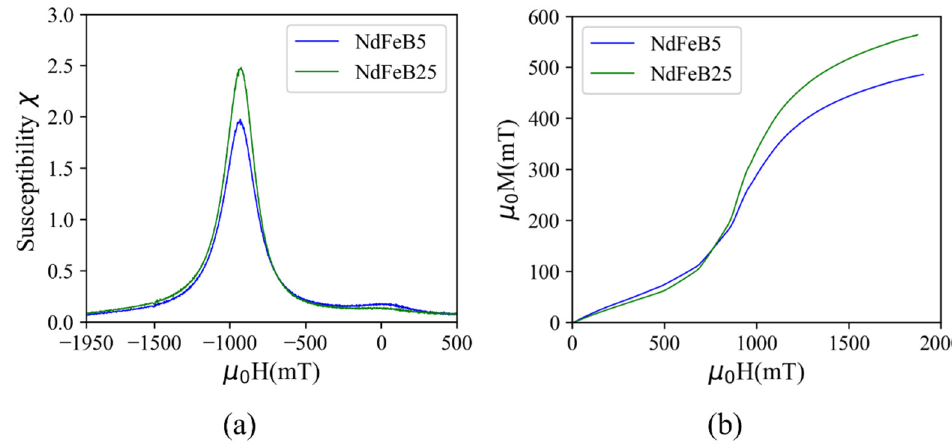
Figure 6. ( a ) Field dependence of the susceptibility χ and ( b ) initial magnetization curves of the ALD agglomerated micromagnets.